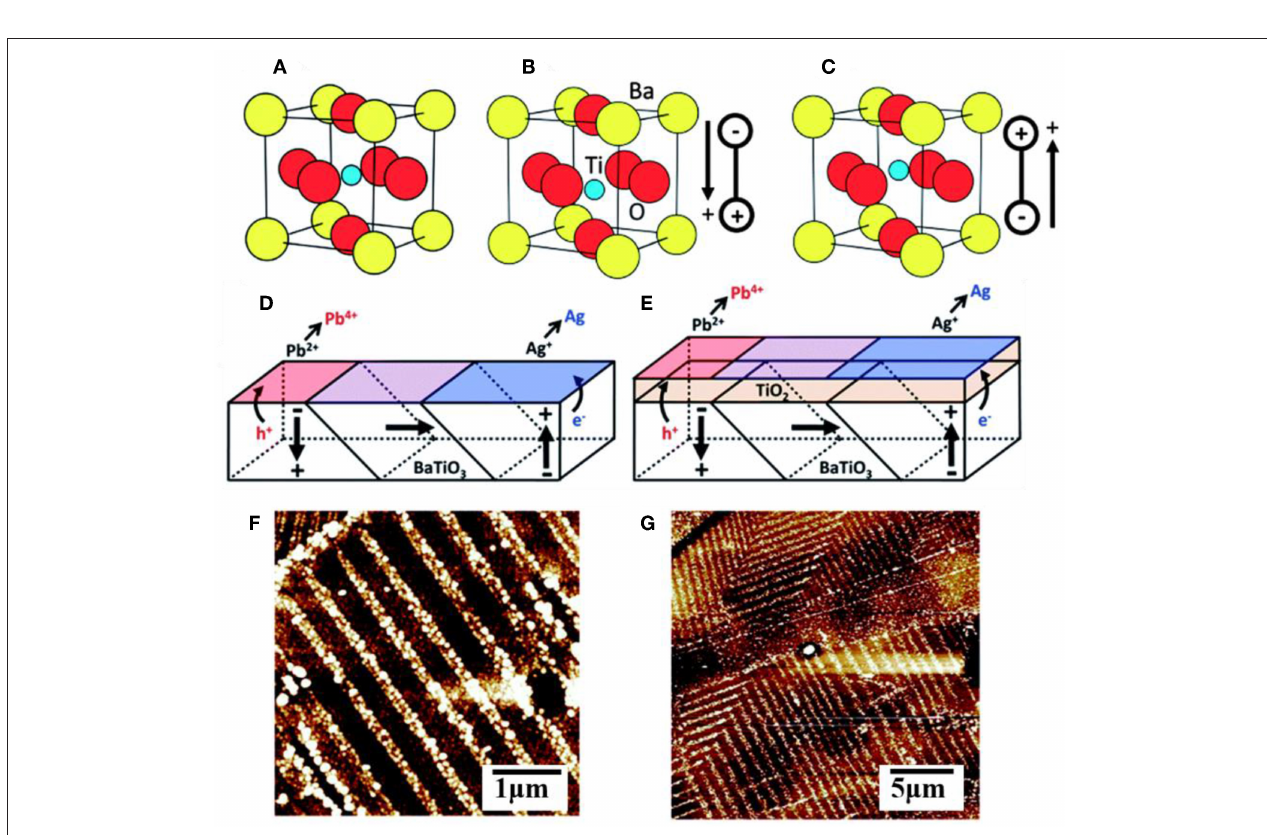
FIGURE 4 | The unit cell of BaTiO 3 in the (A) cubic form and (B,C) in its ferroelectric polymorph showing two different polar orientations. A multidomain surface with multiple polar orientations without (D) and with (E) a TiO 2 layer coating. AFM images of a (100) oriented BaTiO 3 surface after photochemical deposition of metallic Ag (white contrast) without (F) and with (G) the TiO 2 layer coating. Adapted with permission from Giocondi and Rohrer (2001). Copyright 2001 American Chemical Society.